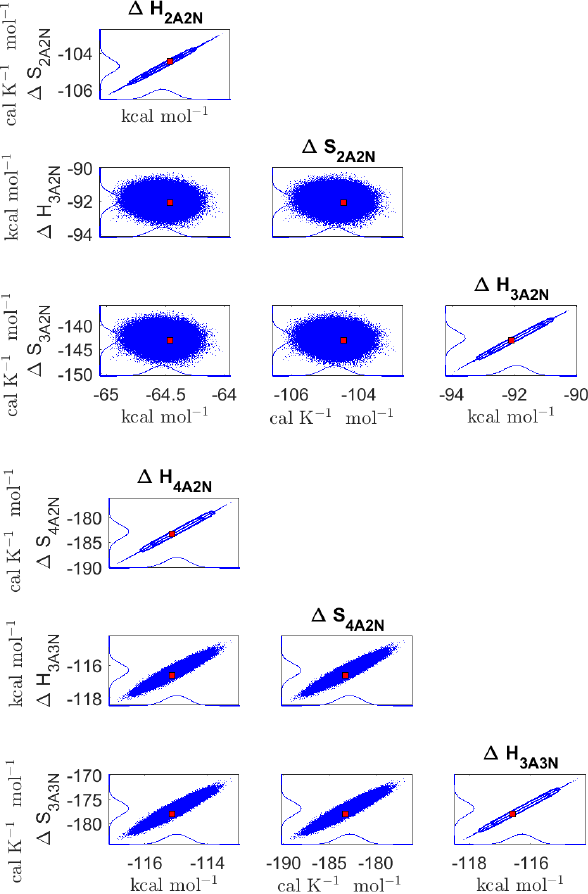
Figure D3. Pairwise marginal posterior distributions (for param- eter indexes ranging from 9 to 16) of the cluster formation en- thalpies and entropies determined from steady-state cluster con- centration measurements at two temperatures ( T = 278K and T = 292K). Red rectangles denote the baseline values from Olenius et al. (2013b) used to generate the synthetic data. Here, the symbols (cid:49) H and (cid:49) S stand for cluster formation enthalpies and entropies, re- spectively. The notation xAyN corresponds to a cluster with x sul- furic acid and y ammonia molecules.